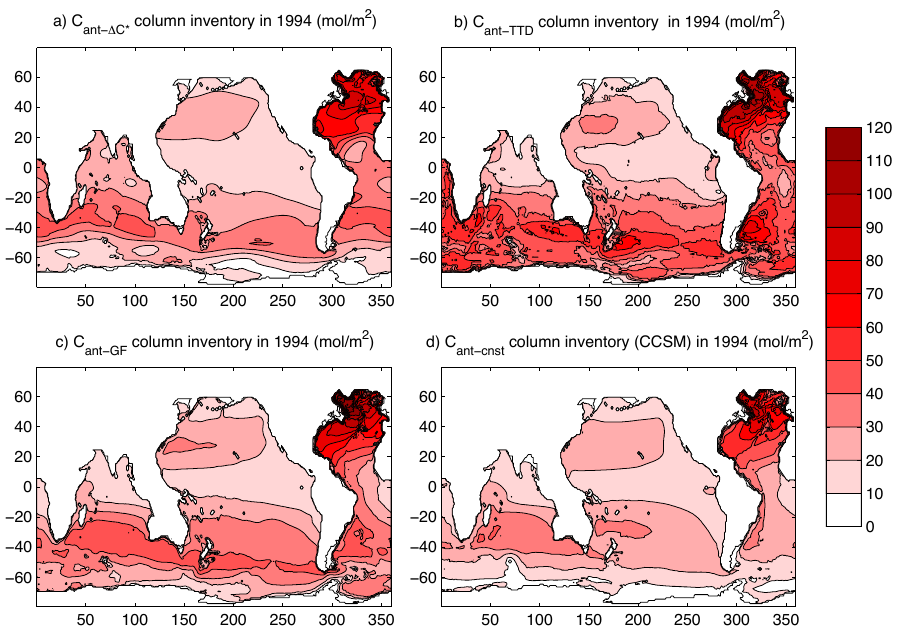
Fig. 1. Column inventories of anthropogenic DIC in year 1994 by (a) the 1 C* method; (b) the TTD method; (c) the GF method; (d) the CCSM (C ant cnst ) .